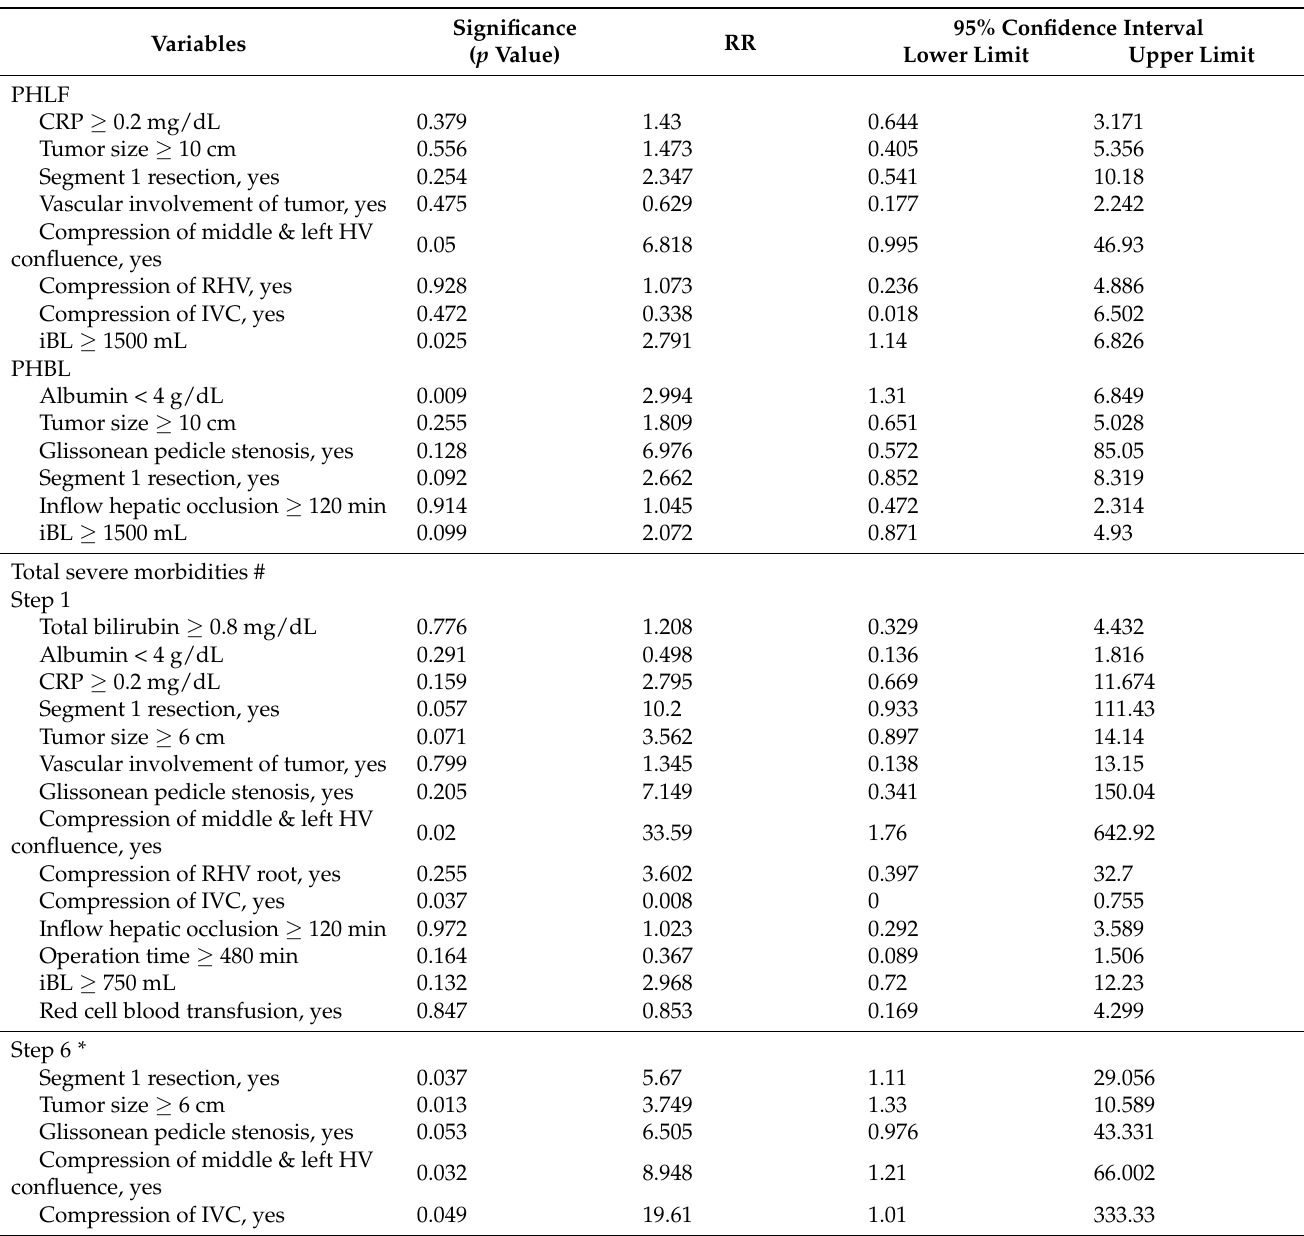
Table 3. Multivariate logistic regression analyses between clinical and surgical parameters and major postoperative morbidity in